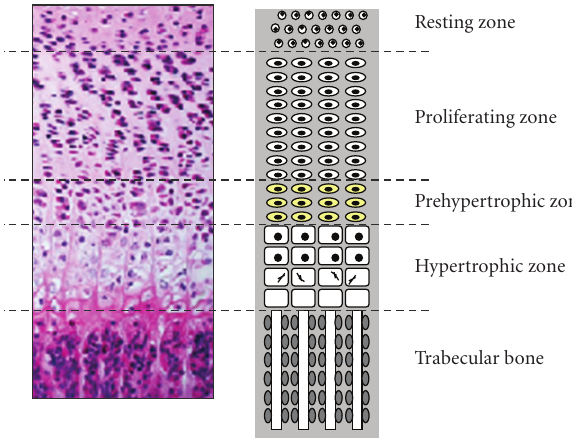
Figure 2: A histological H&E (haematoxylin and eosin) stained image of an adult mouse growth plate and a schematic representa- tion of di ff erentiation zones in the tissue. In the growth plate several distinct structural zones can be identified, reflecting the gradual transition of cells through di ff erent stages of di ff erentiation [13]. Resting zone acts as a reserve of precursor cells for the proliferating chondrocytes in the columns [10]. Proliferating zone is where the cells flatten and divide, laying down a cartilage extracellular matrix that will later serve as a sca ff old for bone formation [14]. In the prehypertrophic zone, the cells enter the maturation zone and begin to enlarge. In the hypertrophic zone, the chondrocytes and their lacunae become 5–12 times bigger [14]. These cells eventually die, triggering vascularisation and bone